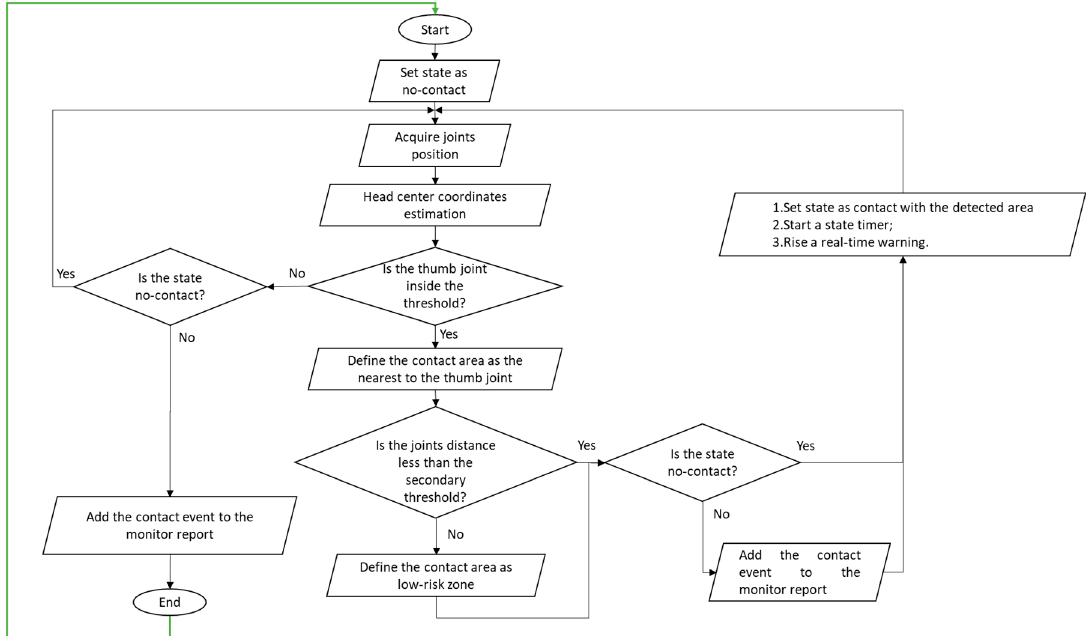
Figure 6. Hand–face contact detection and classification algorithms; the green arrow connecting the end node to the start one indicates that the algorithm is iterated for each newly acquired frame.